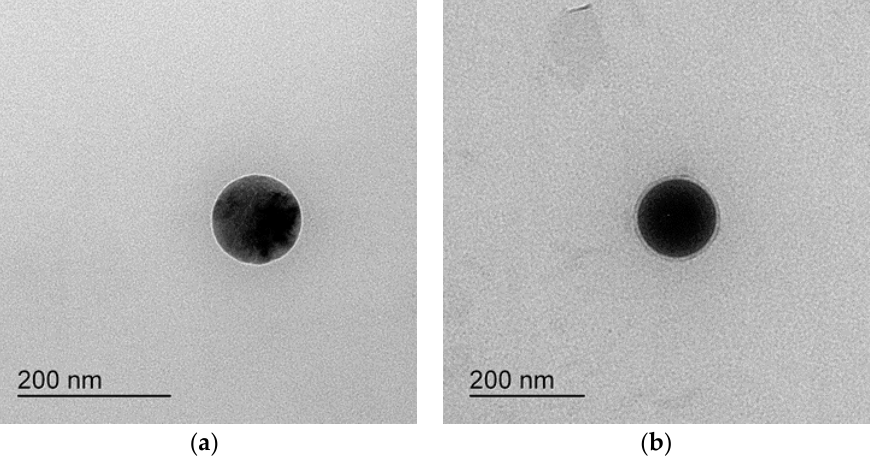
Figure 3. TEM of ( a ) formulation A ‐ 1 and ( b ) formulation B ‐ 1.